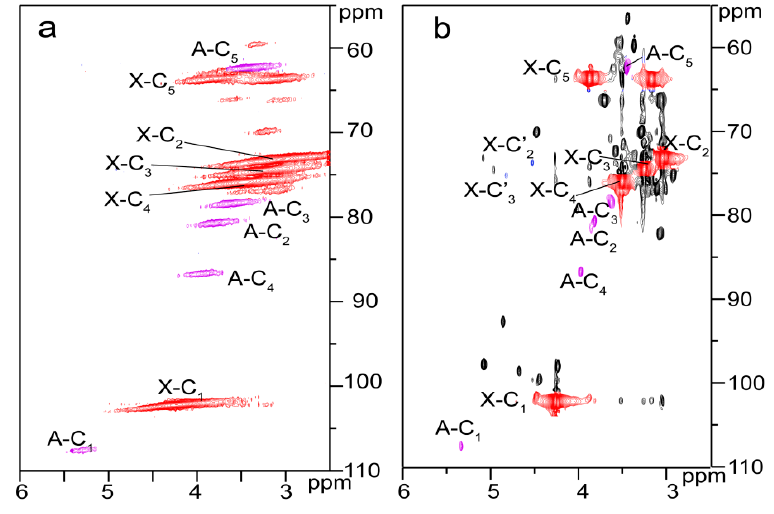
Figure 6. 2D HSQC NMR spectra of unmodified (H0, a ) and esterified (H3, b )